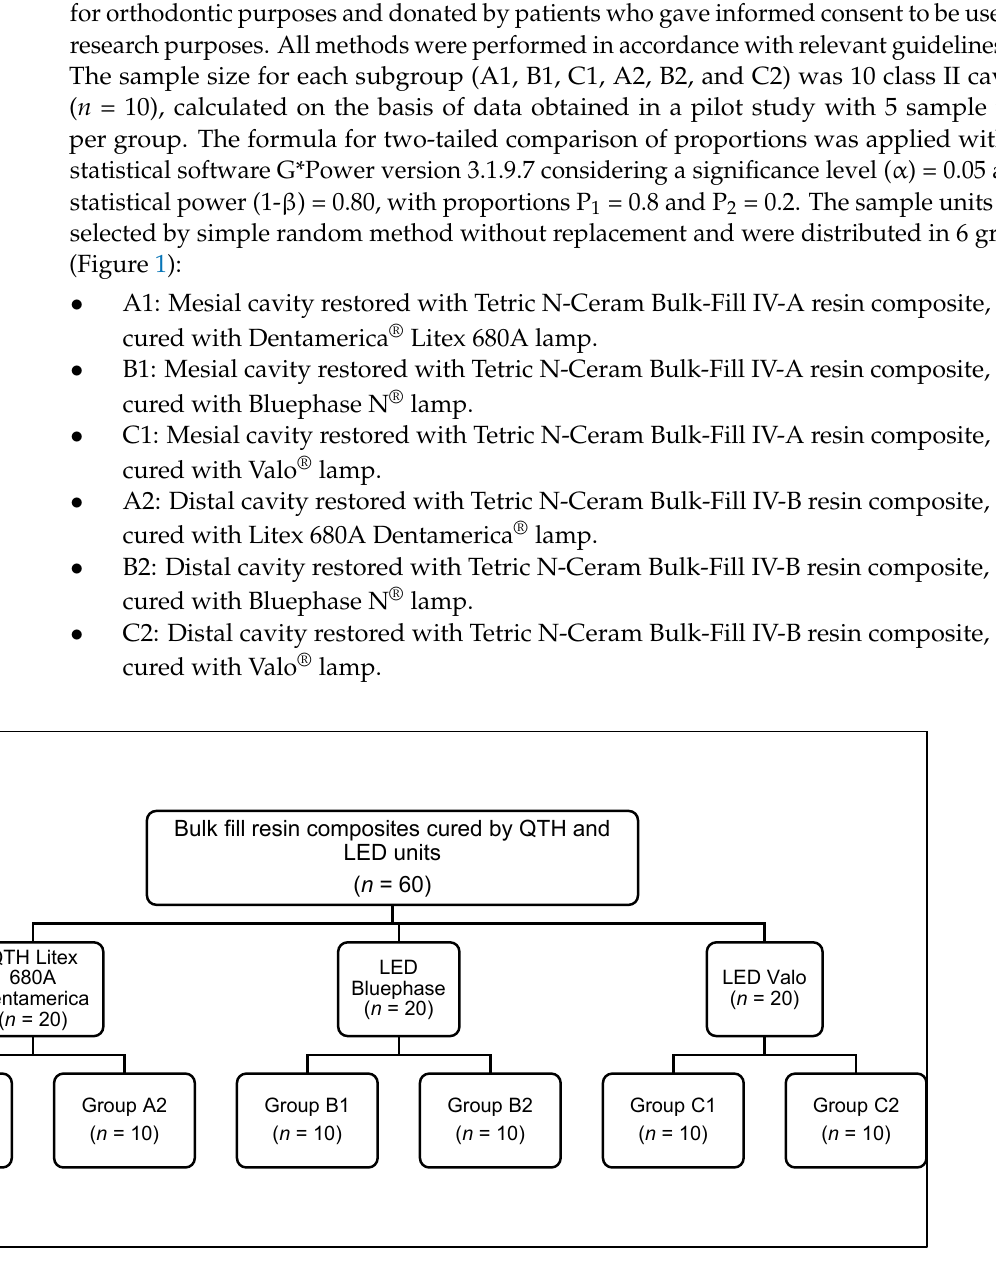
( B ) Figure 2. Class II cavity preparation. ( A ): crown sectioned lengthwise (mesiodistal direction) and ( B ) proximal view.